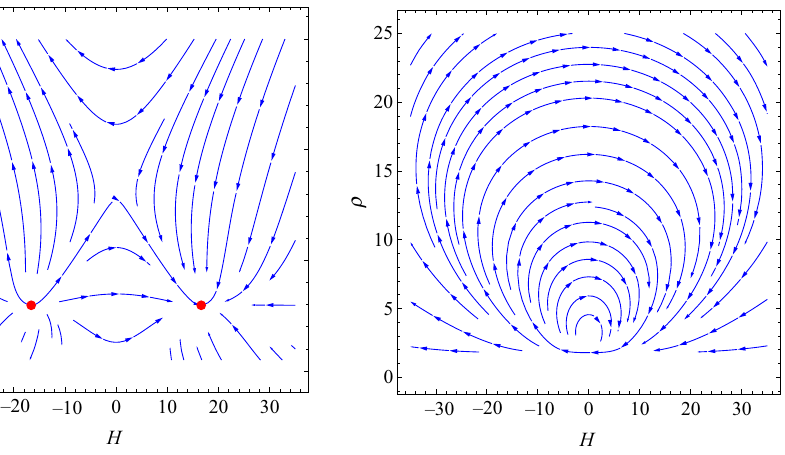
μ = − 1, ρ ∗ = 5, ω = − 0 . 98 , (cid:3) ∗ ∈ ( 0 . 2 , 0 . 5 ) , c 2 ∈ ( 0 , 0 . 5 ] and 0 m s β > − 1. Right panel only corresponds to closed curvature mode with the same numerical values except μ 0 = 1, 0 < ρ ∗ <